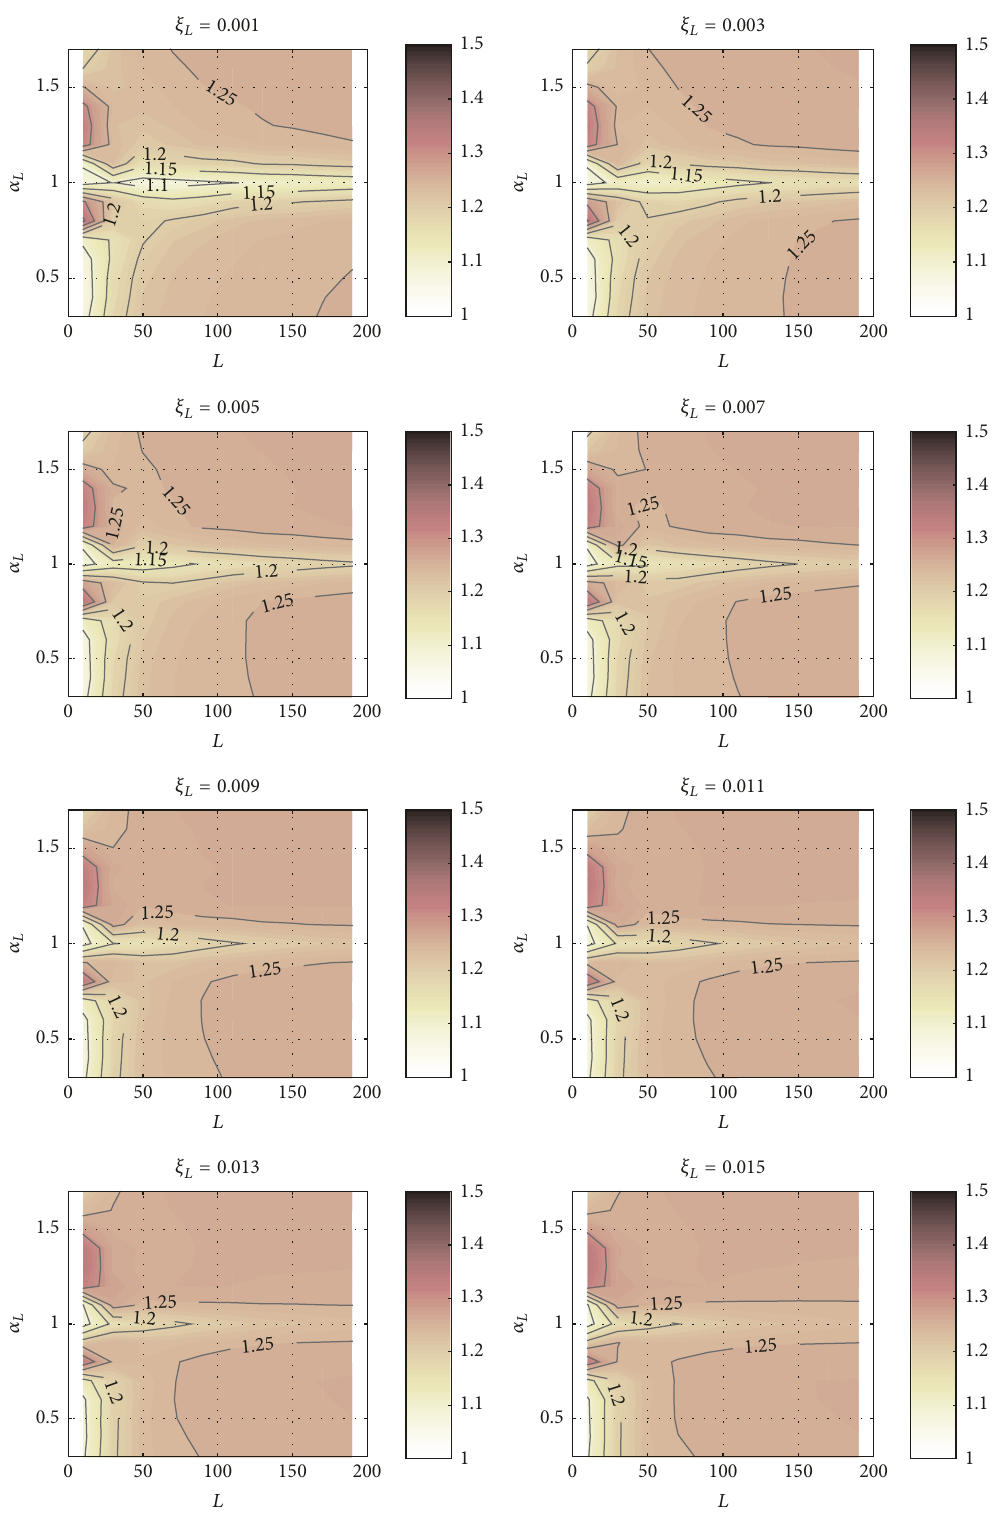
Figure 8: BF 𝐿 ( RL 𝐿 = 1, 𝛼 𝐿 ,𝐿,𝜉 𝐿 ) for different values of 𝜉 𝐿 numerically evaluated using the solution of Abu-Hilal and Mohsen